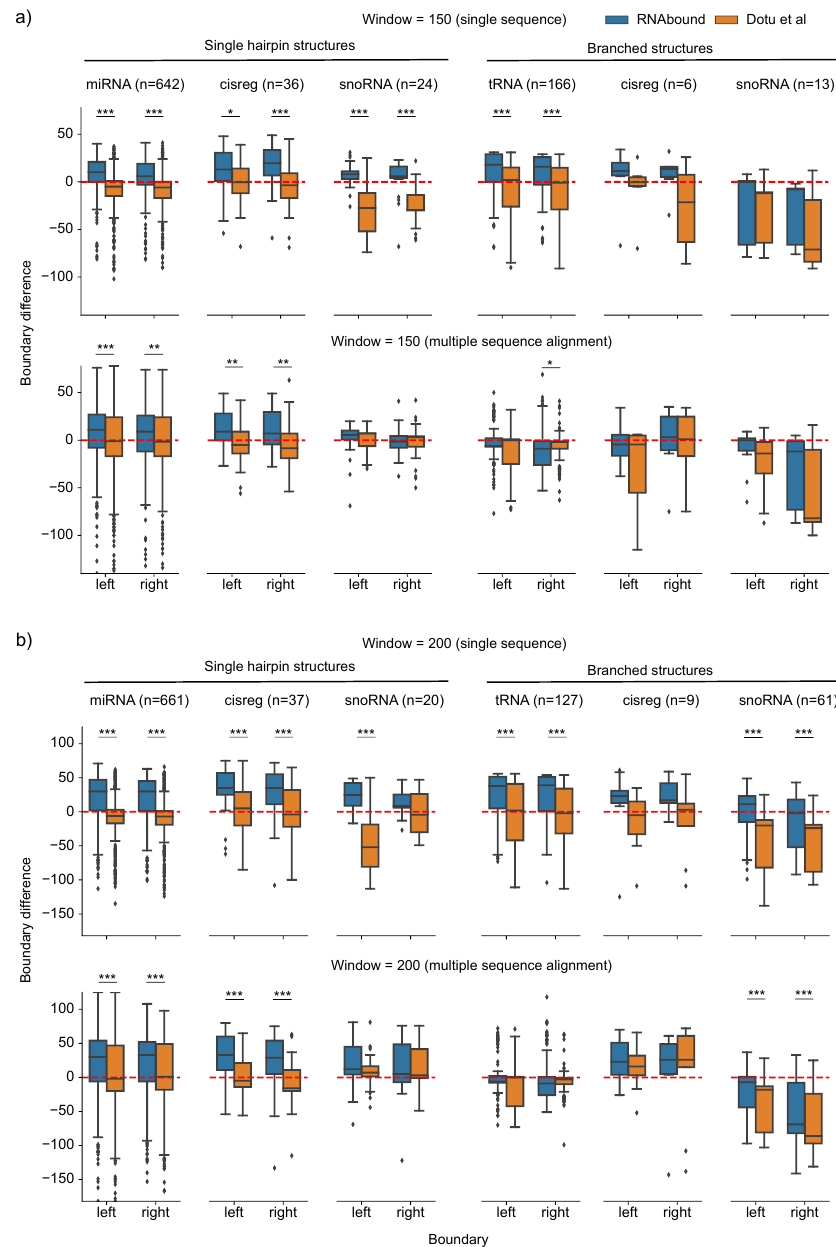
Figure 2. Comparison of actual and predicted boundaries predicted by RNAbound and Dotu et al. on the benchmarking dataset of specific RNA families (Table 1) of different window size 150 ( a ), and 200 ( b ). Under each window category, the top row represents the results obtained from the single sequence and the bottom row from multiple sequence alignment. In both cases, we considered structures whose actual base pair start and end position are within the respective window size. The value on the y-axis indicates if the predicted and actual boundaries are the same (if the value is zero), in excess (positive) or short (negative) of the actual boundaries. The distributions that showed significant difference based on the two-sided Wilcoxon rank-sum test are indicated with asterisk symbol (*** p < 0.001, ** p < 0.01, and * p <